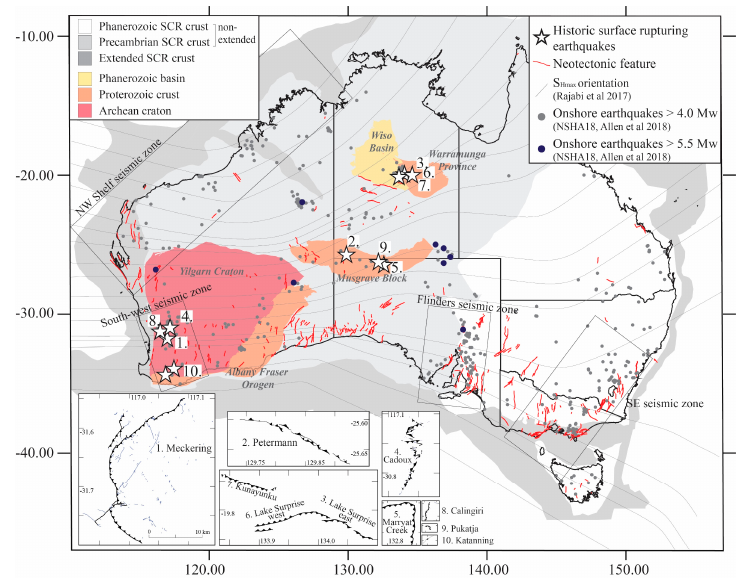
Figure 1. Map of Australia showing locations of historic surface rupturing events, continental scale crustal divisions [99], onshore historic seismology > 4.0 (1840–2017) [11], simplified crustal stress trajectory map [100], GA neotectonic features database [95], recognized seismic zones [101,102] and specific crustal provinces relevant for surface rupture events (Table 3) [103]. Small maps show individual surface ruptures at the same scale and ordered by rupture length (excluding 2018 Lake